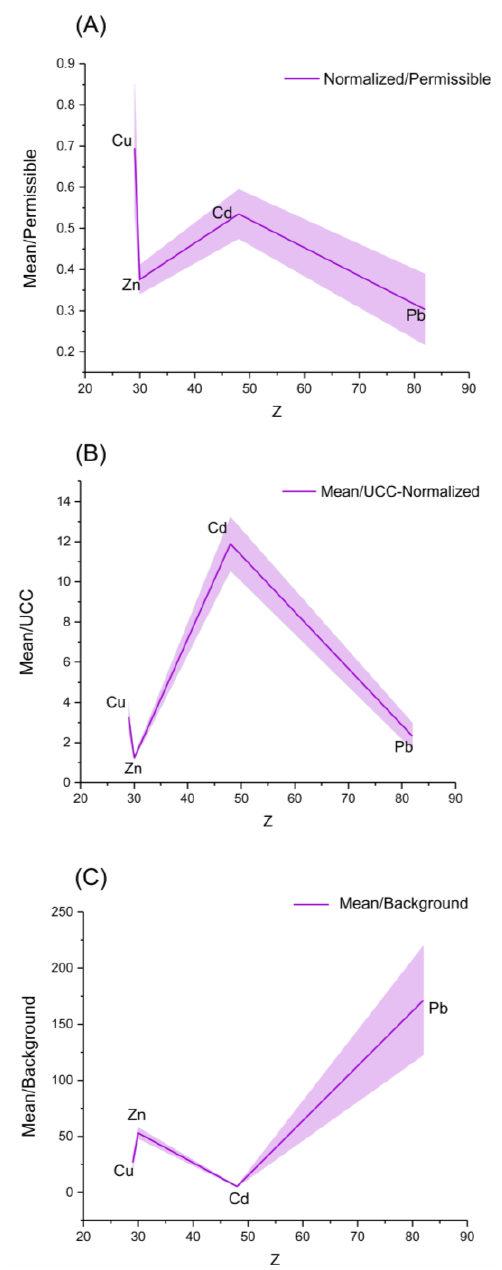
Figure 3. Spidergram shows the normalized mass fractions to various normalizers; the permissible values ( A ), to the upper continental crust UCC ( B ), and background ( C )